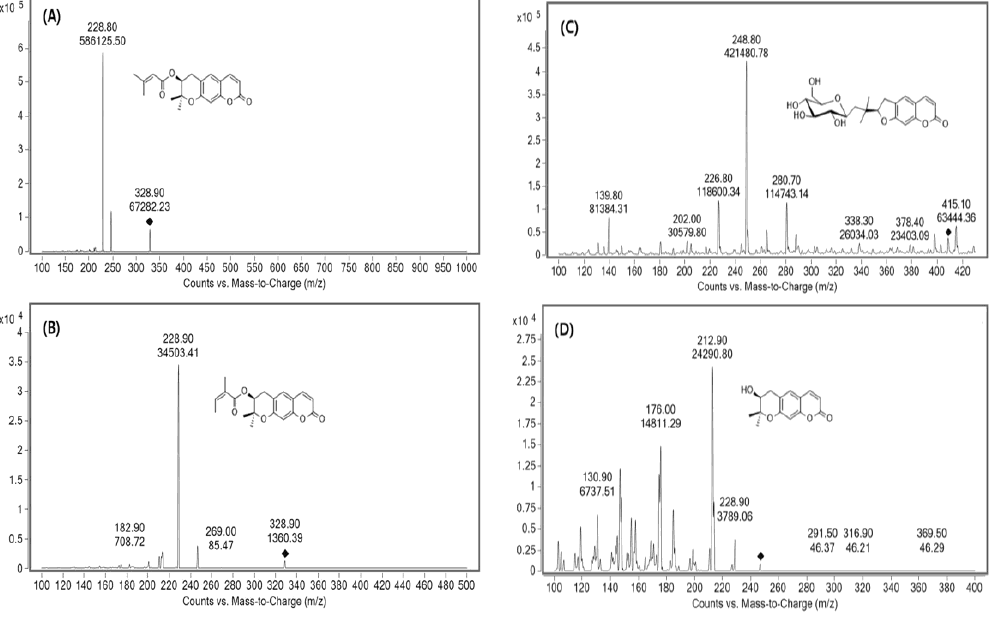
Figure 2. Full scan product ions of precursor ions of ( A ) decursin (328.8 → 228.8), ( B ) decursinol angelate (328.9 → 228.9), ( C ) nodakenin (409.4 → 248.8), and ( D ) decursinol (246.8 → 212.9).